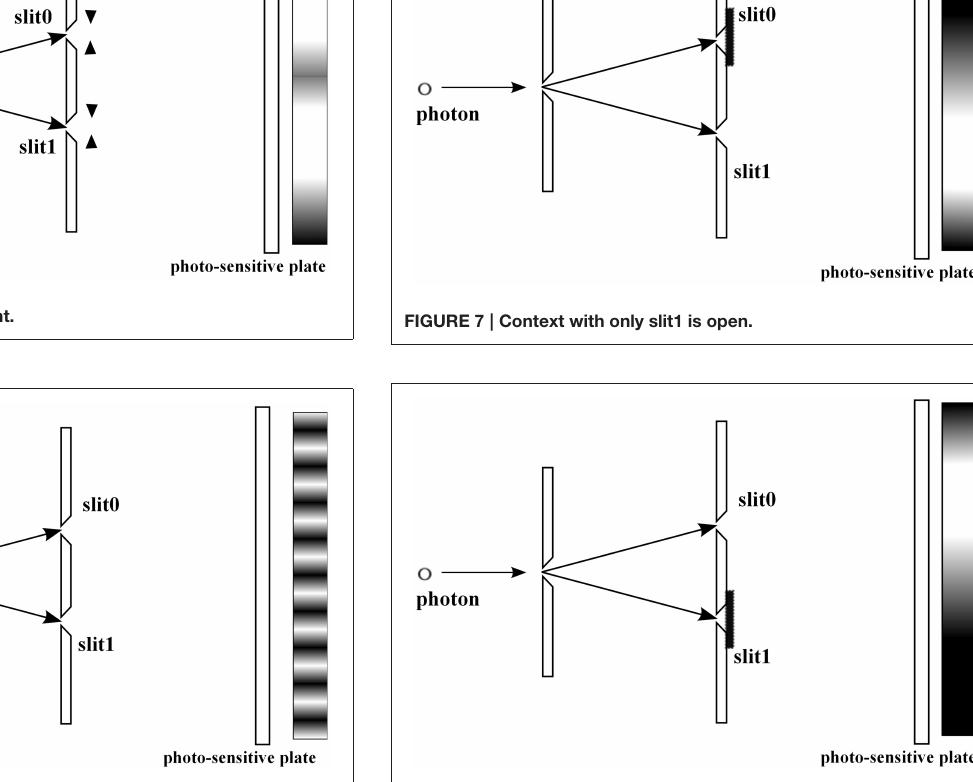
FIGURE 6 | Context with both slits are open.